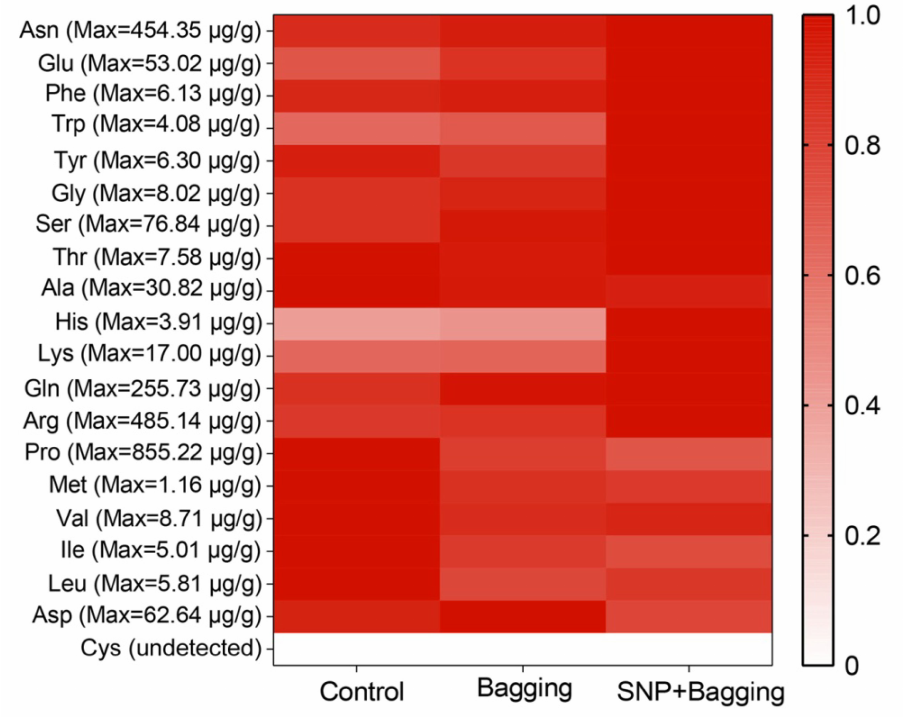
Figure 4. Heatmaps of amino acids in blood orange fruits after different treatments. The bar represents the relative value (measured value/max value × 100%).